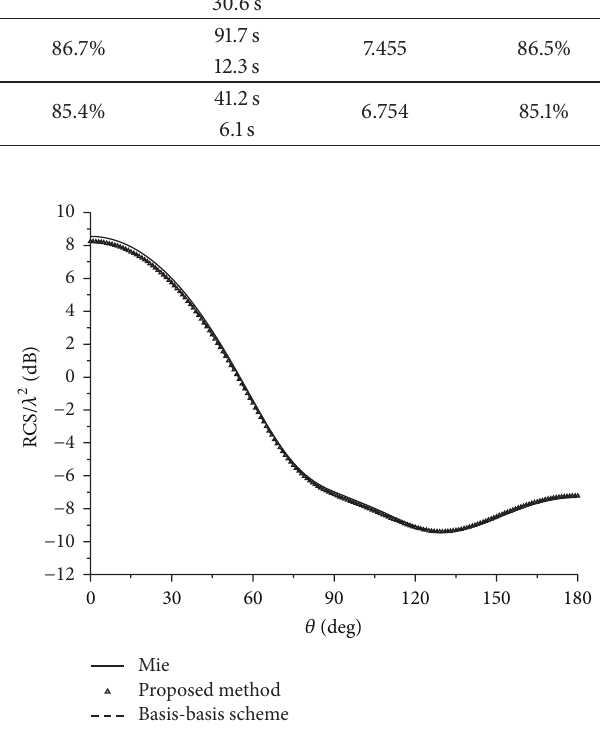
Figure 2: The bistatic RCS curves of the homogeneous